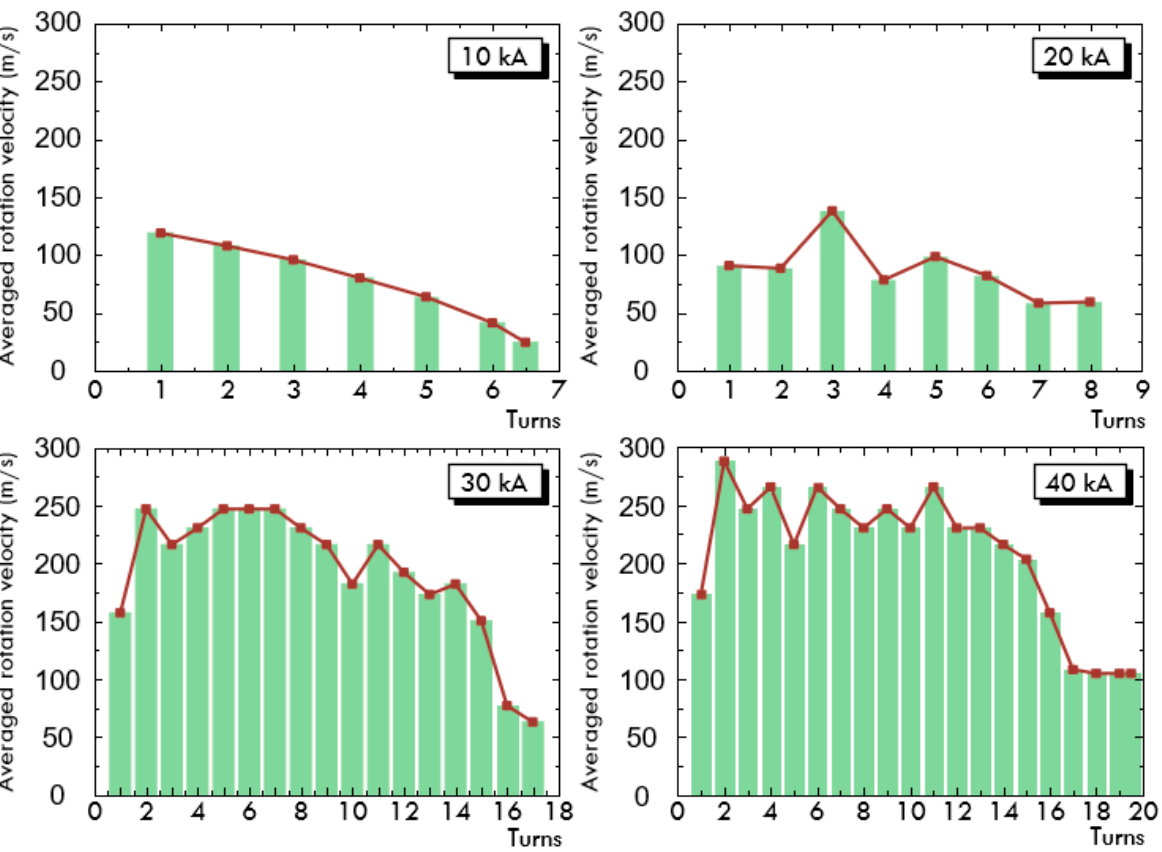
Figure 9. A comparison of the arc rotation velocity under different current levels with a range between 10 kA and 40 kA.